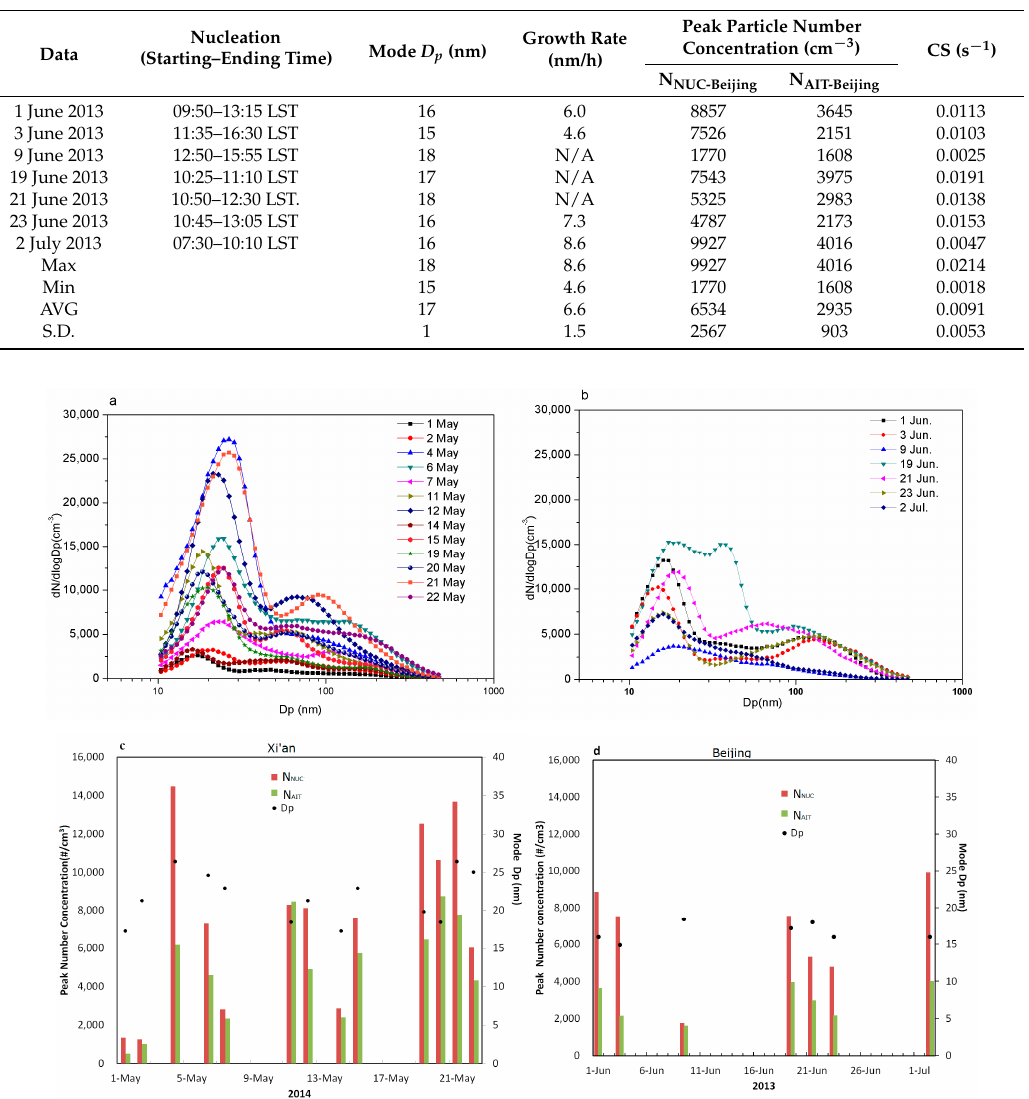
Figure 4. Average number size distributions of freshly nucleated particles at the suburban site of Xi’an ( a ) and the suburban site of Beijing ( b ) during the periods with NPF events as well as maximum peak number concentrations of nucleation and Aitken size mode particles and mode peak diameter (Mode D p ) during the periods with NPF events at the suburban site of Xi’an ( c ) and suburban site of Beijing ( d ).